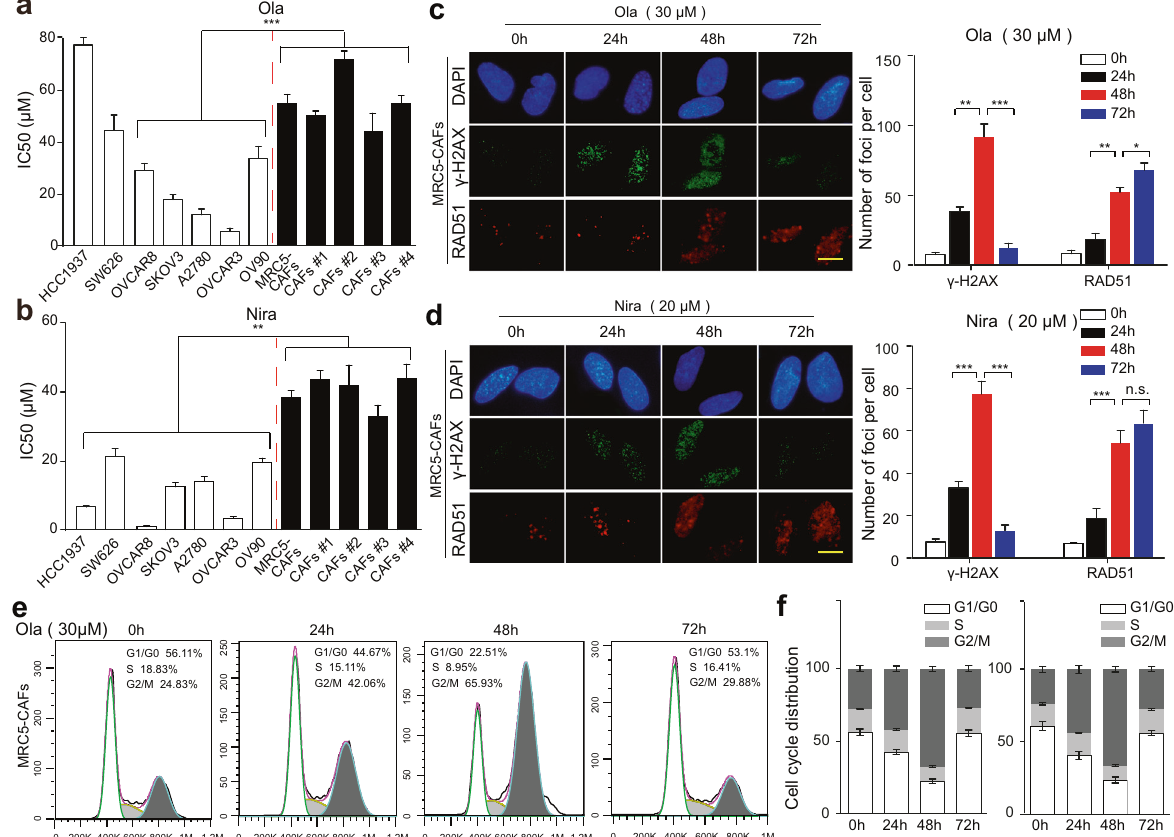
Fig. 1 OC stromal fi broblasts are inherently not vulnerable to PARPis. a , b OC cell lines (SKOV3, OVCAR3, OVCAR8, A2780, OV90, and SW626), breast cancer cell line HCC1937, and CAFs (MRC5-CAFs and four primary CAFs) were treated with a range of concentrations of Ola or Nira for 72 h and were then assayed using CCK-8 for cell viability and IC50. c , d Representative microphotographs and the quanti fi cation of RAD51 and γ -H2AX foci formed in MRC5-CAFs upon exposure to 30 μ M Ola or 20 μ M Nira for the indicated periods. Scale bar, 5 µm. e , f Representative images and the quanti fi cation of changes in the cell cycle distribution of CAFs treated with 30 μ M Ola for the indicated periods. Data are expressed as mean ± s.e.m., * p < 0.05; ** p < 0.01; *** p <